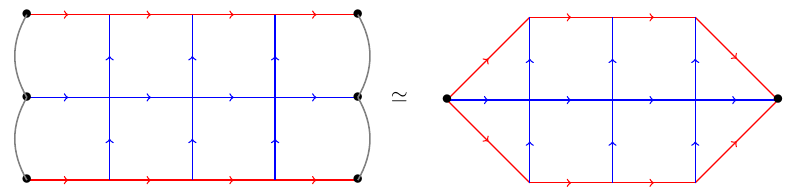
Figure 6 . The interior and boundary faces of a graph. Figure reproduced from [3]. The key-point is that some boundary faces might not be plain square plaquettes.